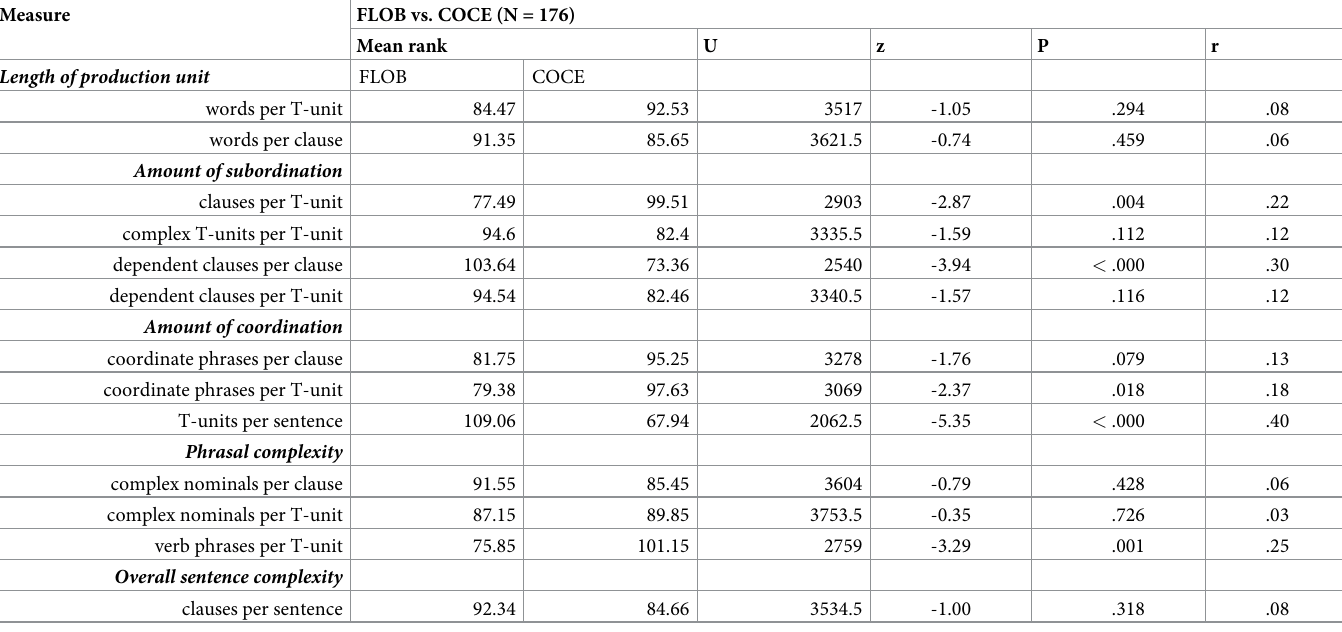
Table 6. Mann-Whitney tests on syntactic complexity between FLOB news and COCE